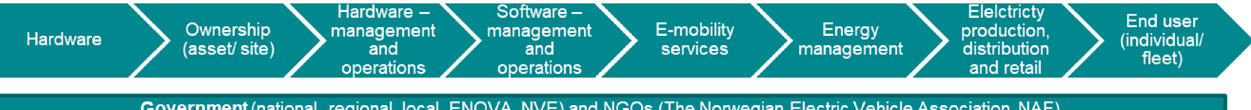
Figure 1. Illustration of the value chain for electric car charging.